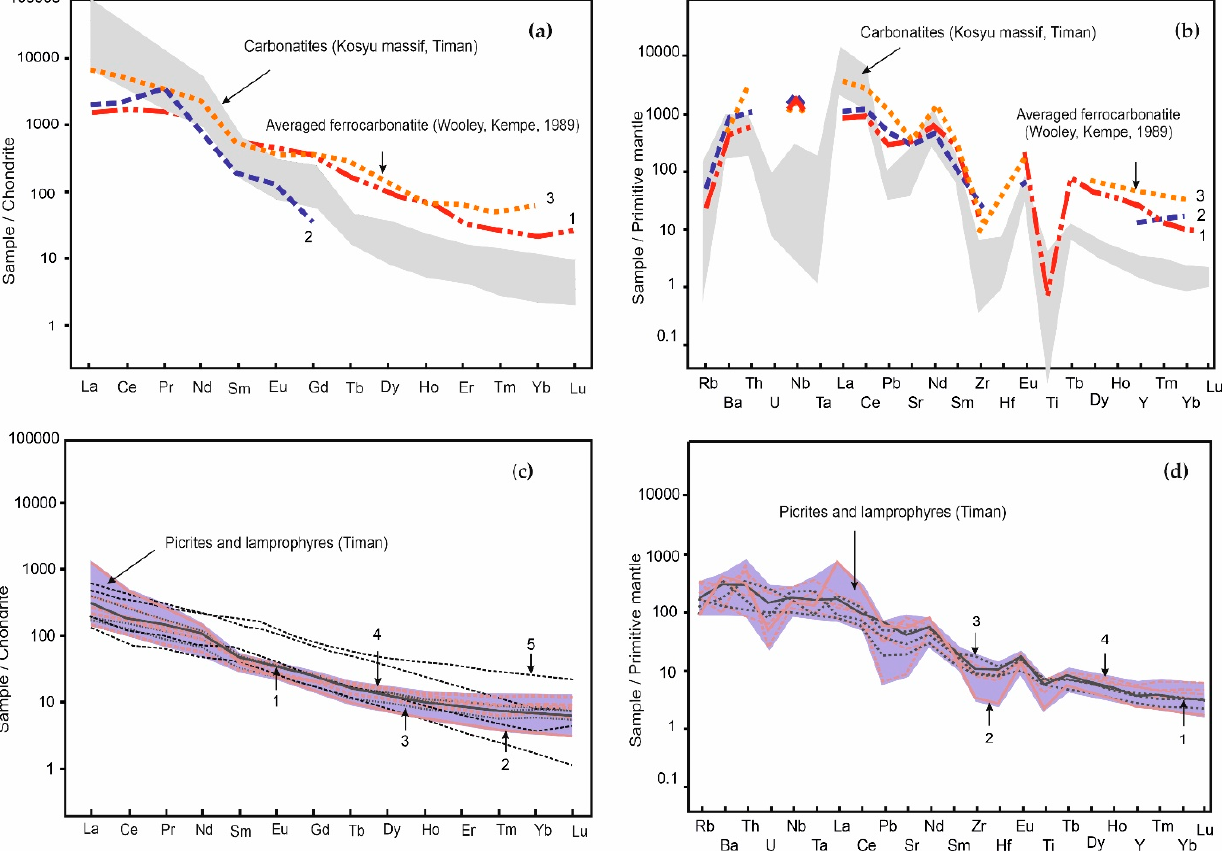
Figure 7. Chondrite-normalized REE patterns and spider-diagrams for carbonatites and ultramafic dyke rocks of the Chetlassky complex, Middle Timan: ( a , b ) carbonatites (grey field); for comparison, average composition for calciocarbonatite (1), magnesiocarbonatite (2), and ferrocarbonatite (3), according to [101] are presented; ( c , d ) picrites and lamprophyres (blue field); 1—picrite, 2—alkaline picrite, 3—lamprophyres, 4—carbonate-bearing lamprophyres, 5—aillikites (Aillik Bay, Labrador) according to [108].